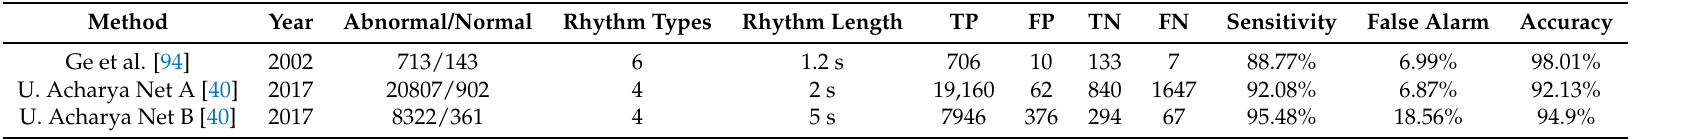
Table 5. Rhythm classification performance on the MIT-BIH